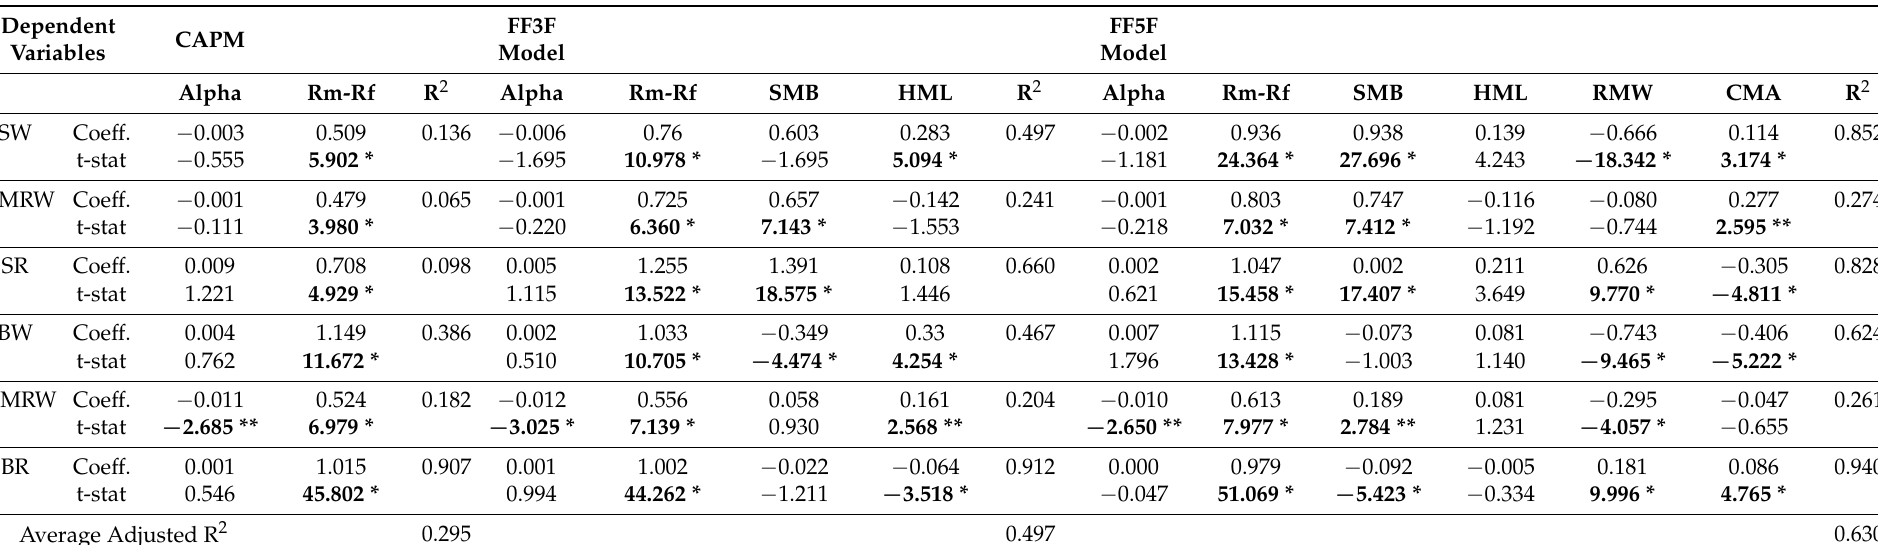
Table 7. Regression results of the CAPM, FF3F model and FF5F model for the 6 value-weighted size–OP portfolios (July 2002–June